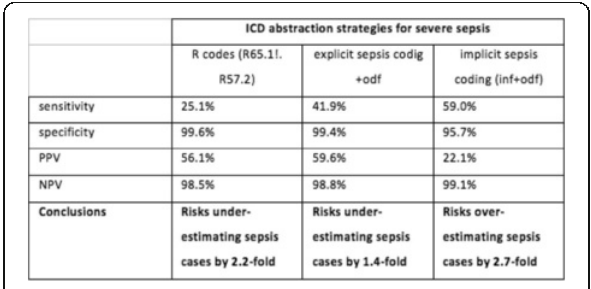
Fig. 42 (abstract A110). Validity of different ICD abstraction